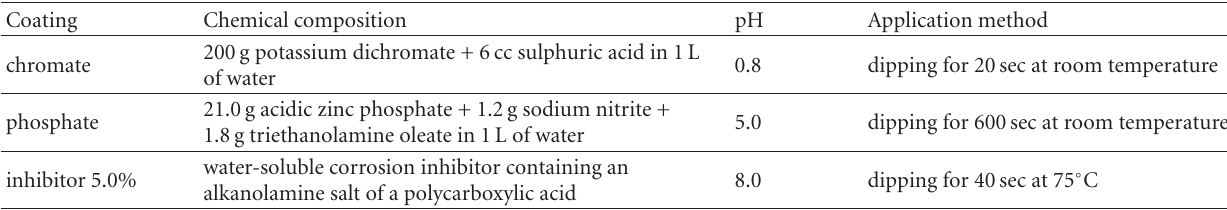
Table 1: Some characteristics of the tested